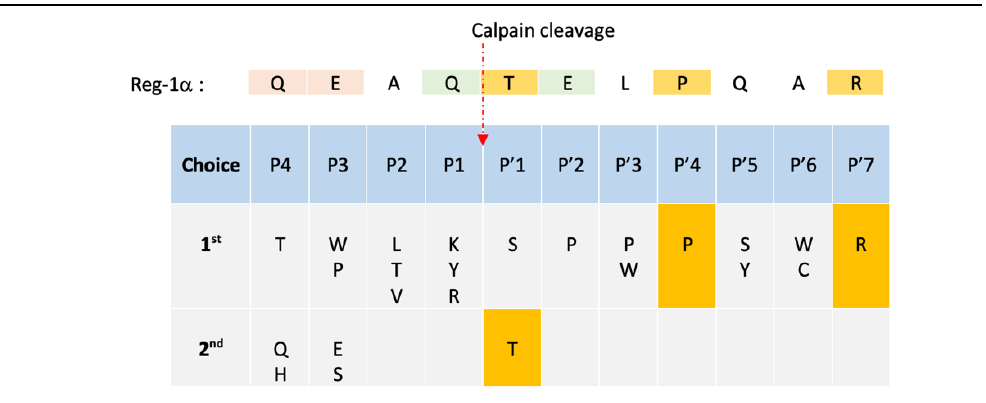
Table 1. Sequence alignment of Reg - 1α NH 2 terminus around the cleavage site with a sequential preference matrix of calpain according to [38].